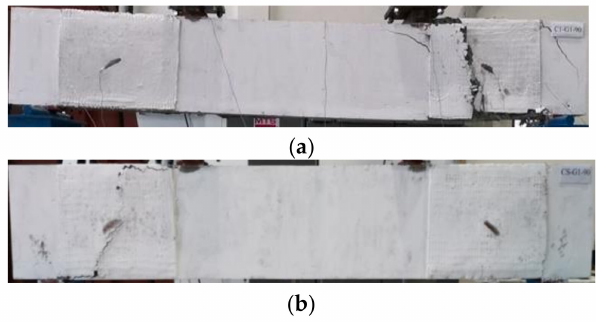
Figure 9. Specimens in group C at failure: ( a ) ST-C1-90; ( b ) ST-C2-90.